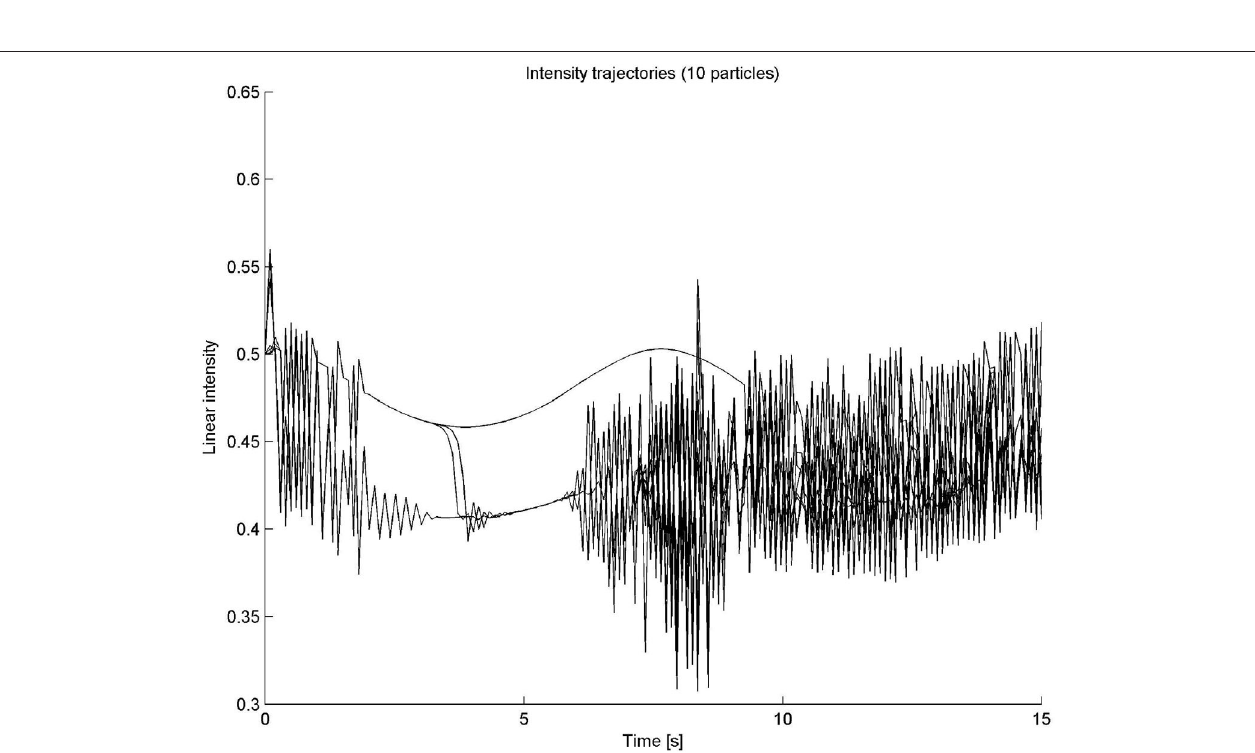
FIGURE 7 | Intensity trajectories in time for a 10-particle system. As it can be seen, highly complex behavior can be generated with a few simple if-then rules.